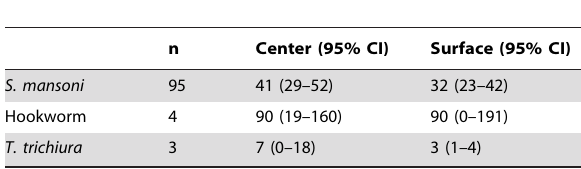
Table 4. Mean eggs per gram (EPG) values in surface and center of stool samples, among 102 helminth-positive participants from Azaguie´ Coˆte d’Ivoire, in